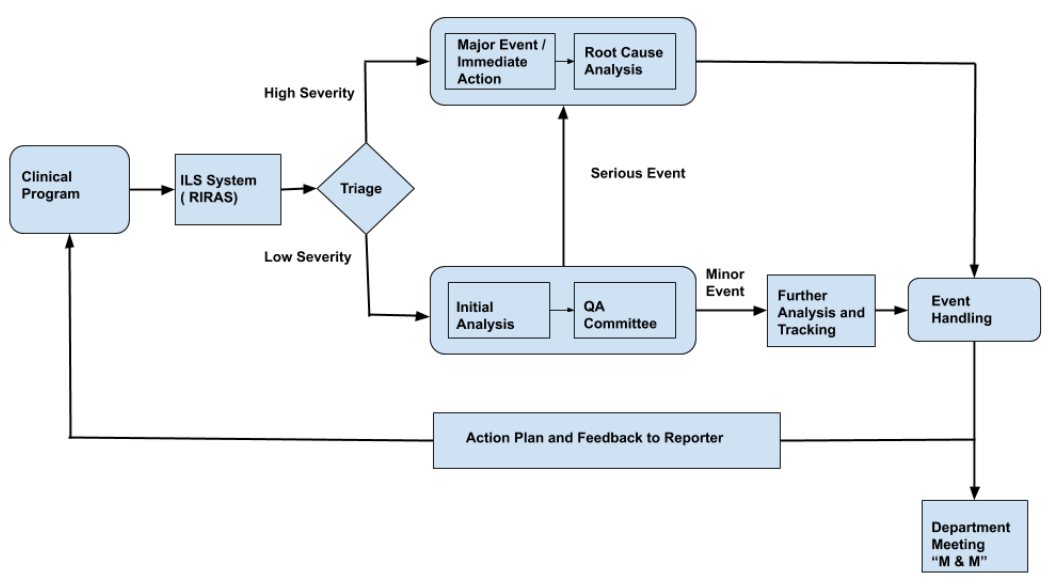
Figure 1. Schematic Representation of Radiation Oncology—Incident Learning System (RIRAS). M & M: Morbidity and